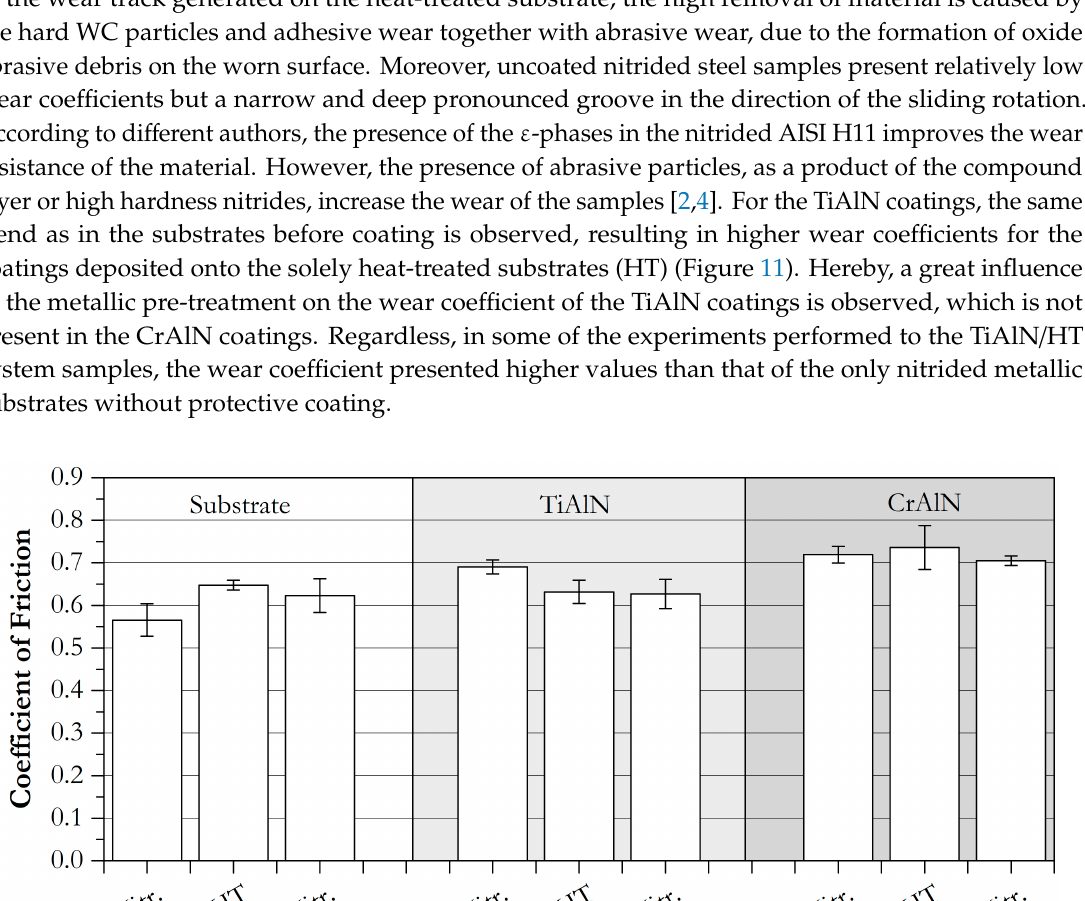
Figure 12. Coefficient of friction of the substrate after pre-treatments and of the coatings when using WC-Co.